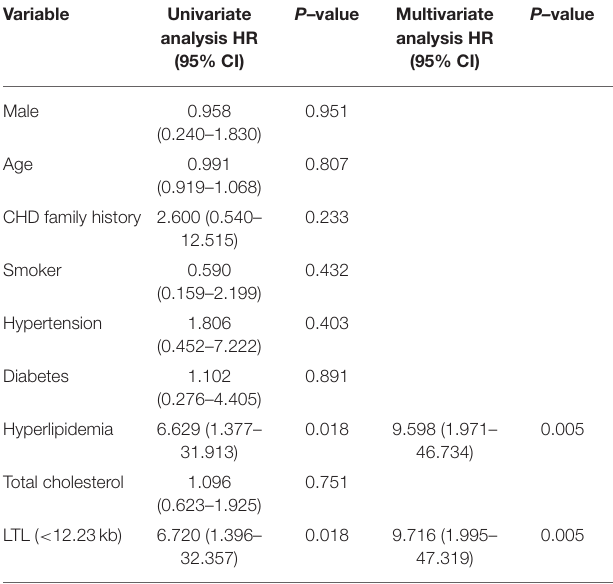
TABLE 4 | Multiple Cox analysis for the major adverse cardiovascular